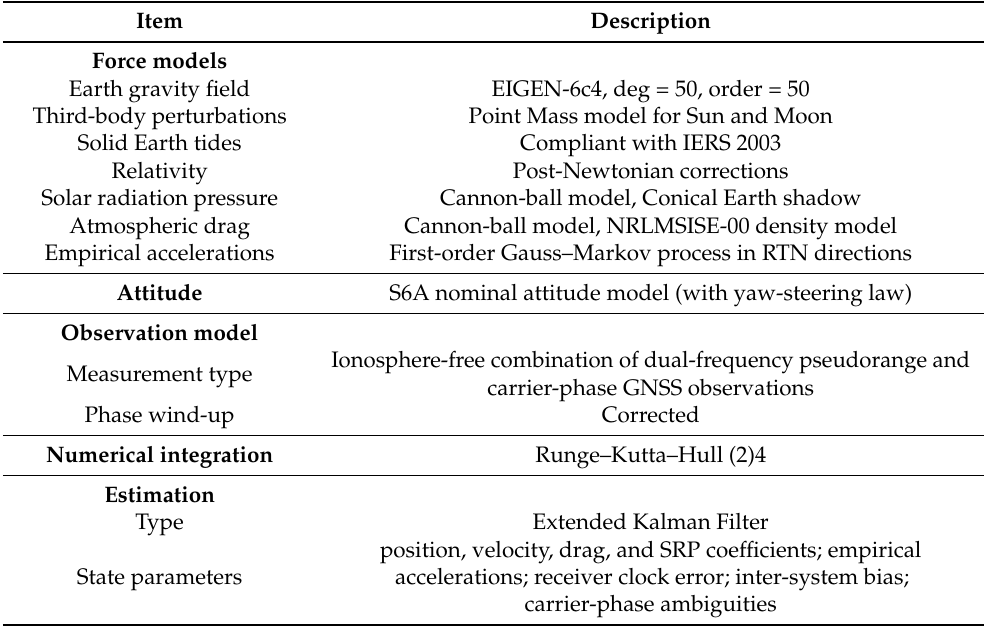
Table 2. Force, observation, and estimation models employed in the orbit-determination